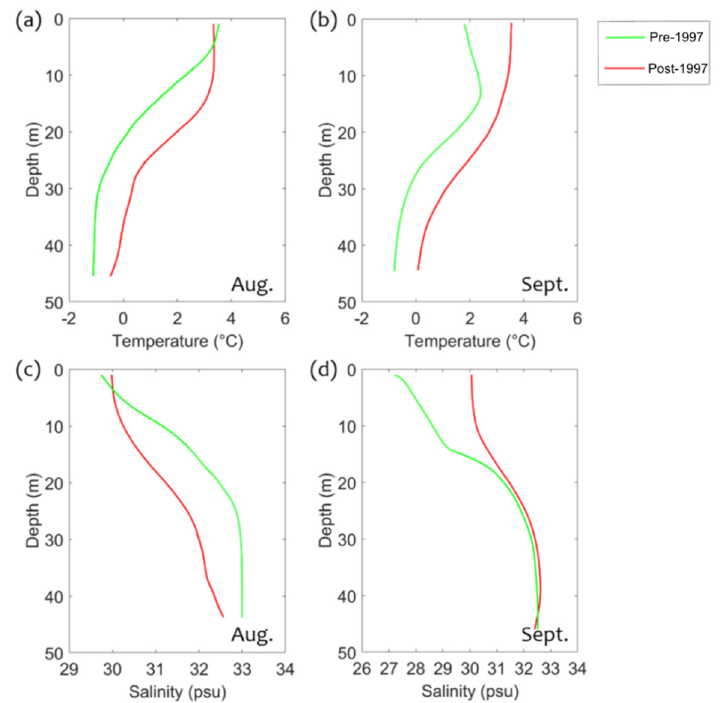
Figure 15. As Figure 13, but for northern Chukchi shelf. Figure 15. The regional average ( a , b ) T and ( c , d ) S profiles of the northern Chukchi shelf in August and September. The green and red lines represent the average values of the pre- and post-1997 periods,